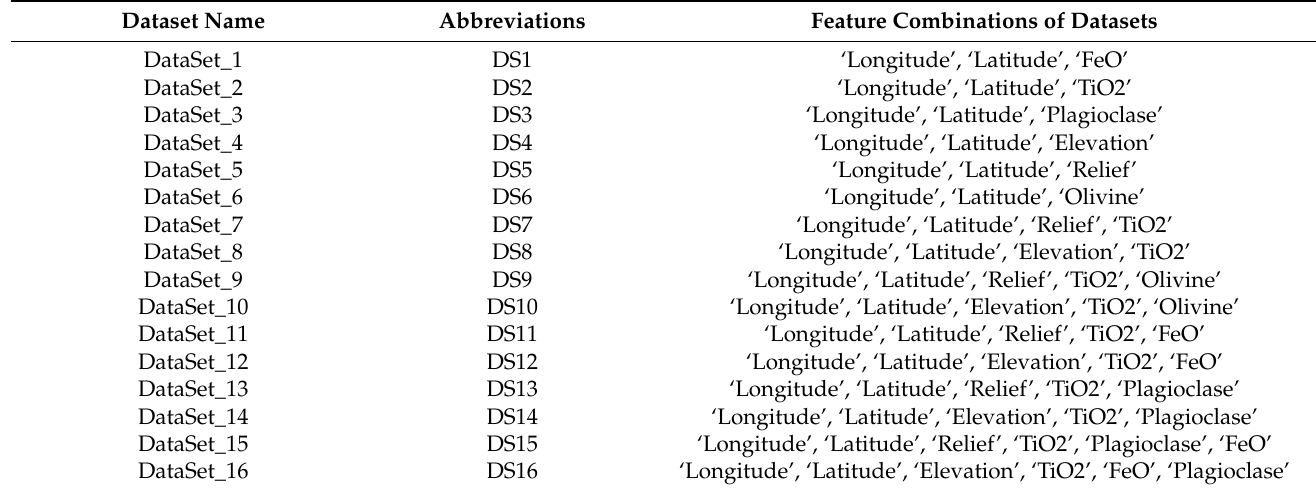
Figure 4. Ranking of feature importance evaluation of two study areas. ( a , c ) Scores of feature importance of Chang’e-4 and Chang’e-5 study areas, respectively, based on the nearest neighbor model. ( b , d ) Scores of feature importance of Chang’e-4 and Chang’e-5 study areas, respectively, based on the application of the integrated algorithm of XGBoost. Table 2. Feature dataset formed by combination of important